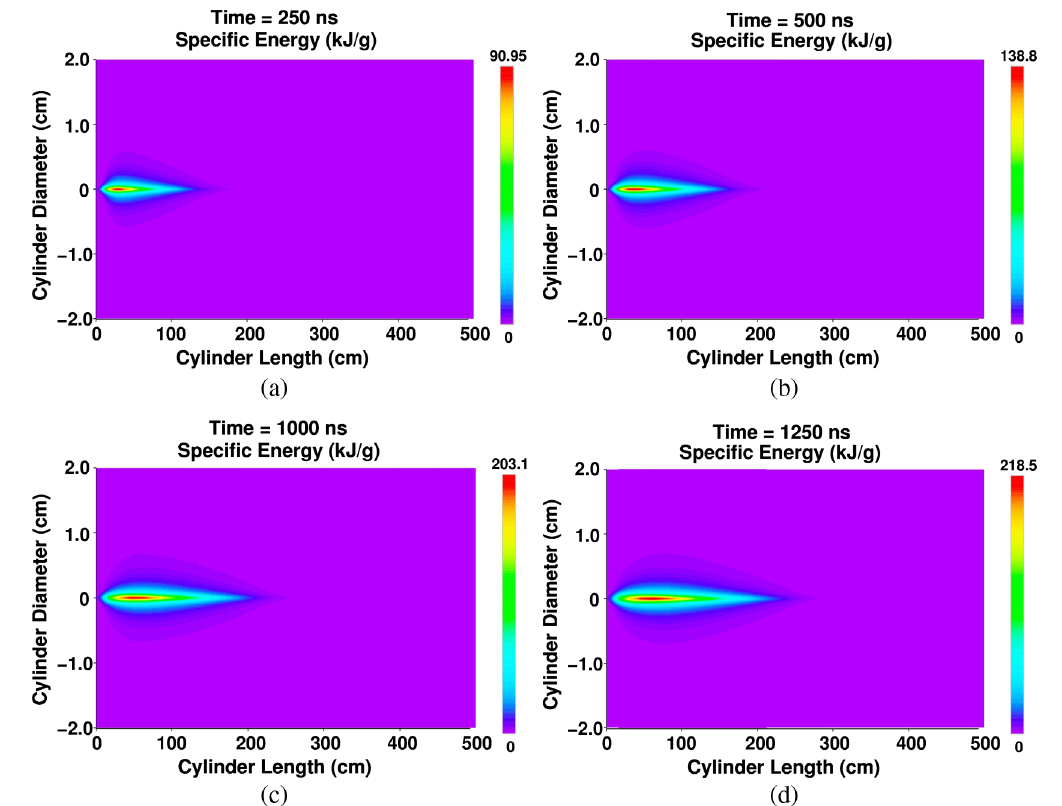
FIG. 2. Specific energy deposition in the target calculated by BIG 2 (a) at t ¼ 250 ns (10 bunches delivered), (b) at t ¼ 500 ns (20 bunches delivered), (c) at t ¼ 1000 ns (40 bunches delivered), and (d) at t ¼ 1250 ns (50 bunches